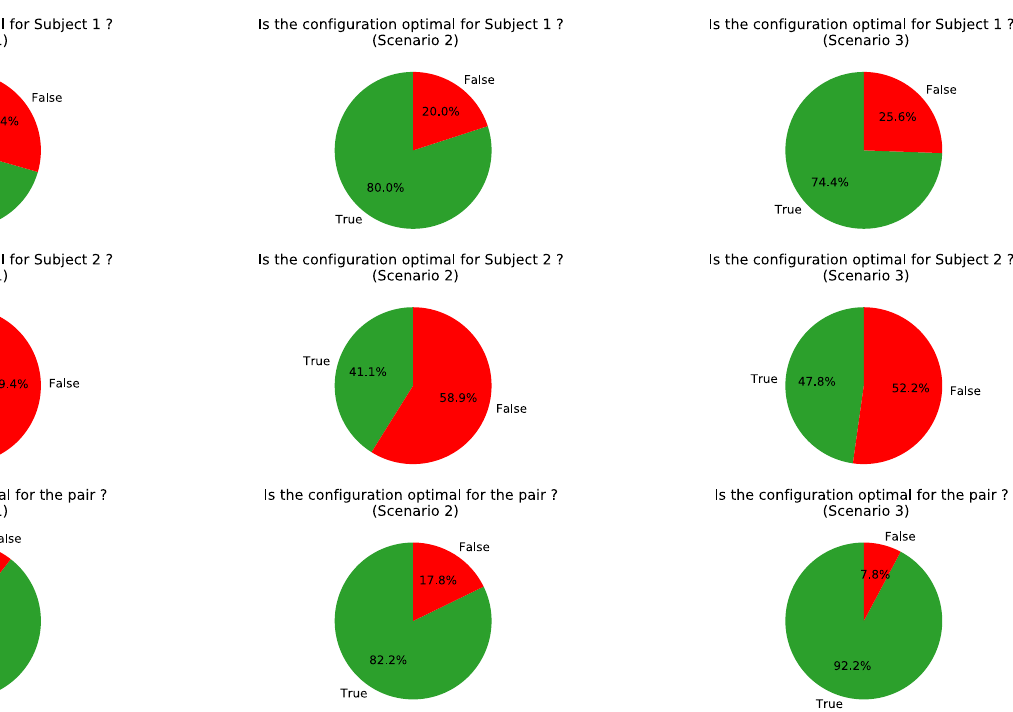
Figure 6. When the table configuration minimizes the travelled distance of Subject 1, Subject 2 and the pair, it is called optimal. These pie charts show the percentage of experiments where the pair put the table in an optimal configuration for Subject 1 (at the top), for Subject 2 (in the middle) and for the pair (at the bottom) according to the different